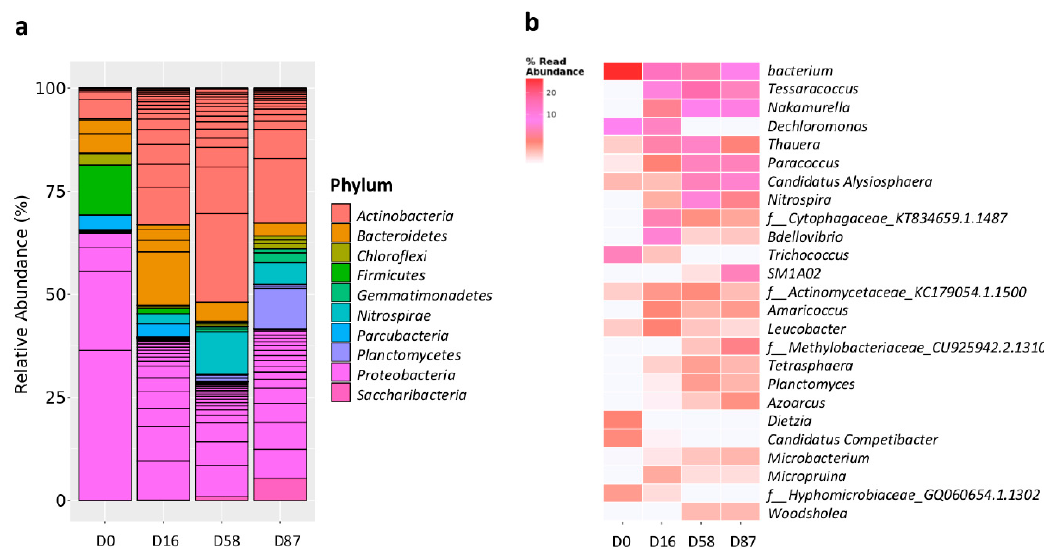
Figure 6. Metagenomic analysis of prokaryotic community. Distribution of ( a ) the major bacterial phyla, identified at four timepoints during MBR operation. The scale in the y axis reflects the normalized relative abundance percentages (%). Black lines within each bar separates each Phylum into lower taxonomic levels and ( b ) the relative abundances of the top 25 bacterial genera, identified in the four timepoints visualized through heatmap.